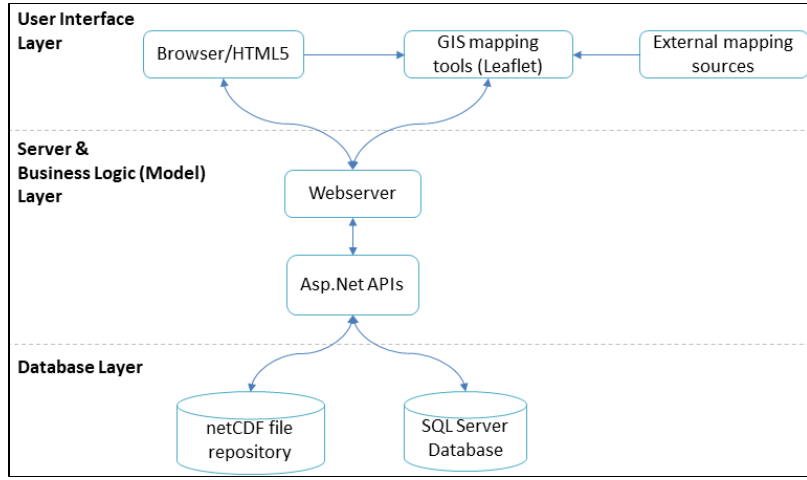
Figure 4. Elements of the layer architecture of the IDF_CC tool.